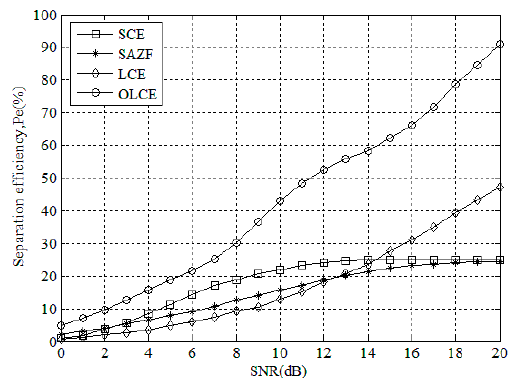
Figure 8. Separation efficiency for SCE, SAZE, LCE, and OLCE under different SNR when the number of collided tags is four.